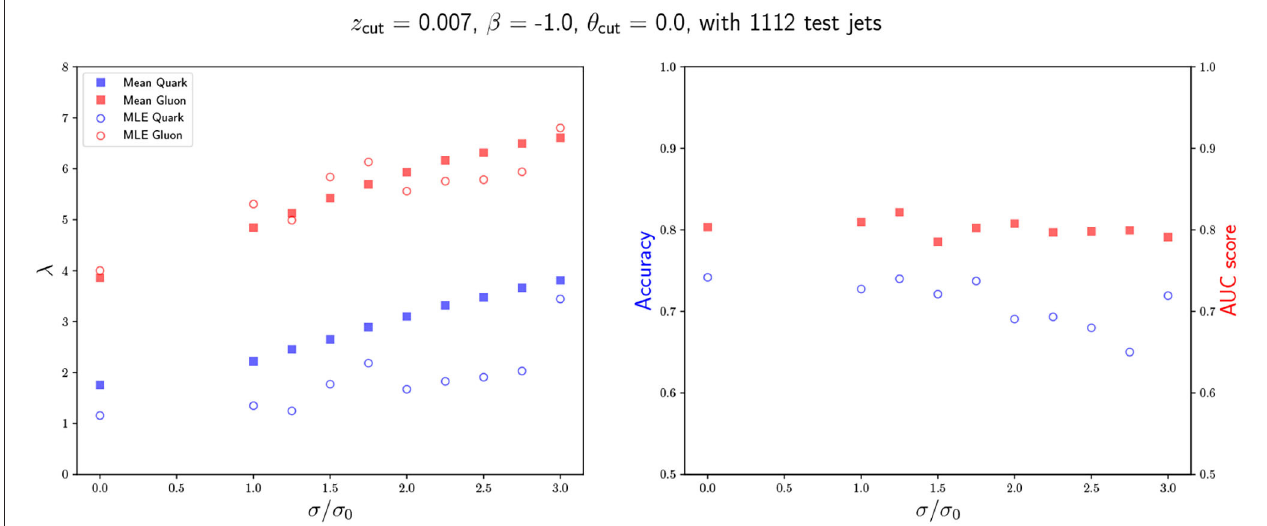
FIGURE 6 | Model performance as a function of the angular smearing. In the left plot we show the obtained Maximum Likelihood Estimates for each Poisson rate and compare them with the means of the true underlying distributions. In the right plot, we show the accuracy and the AUC as a function of the scaling factor.